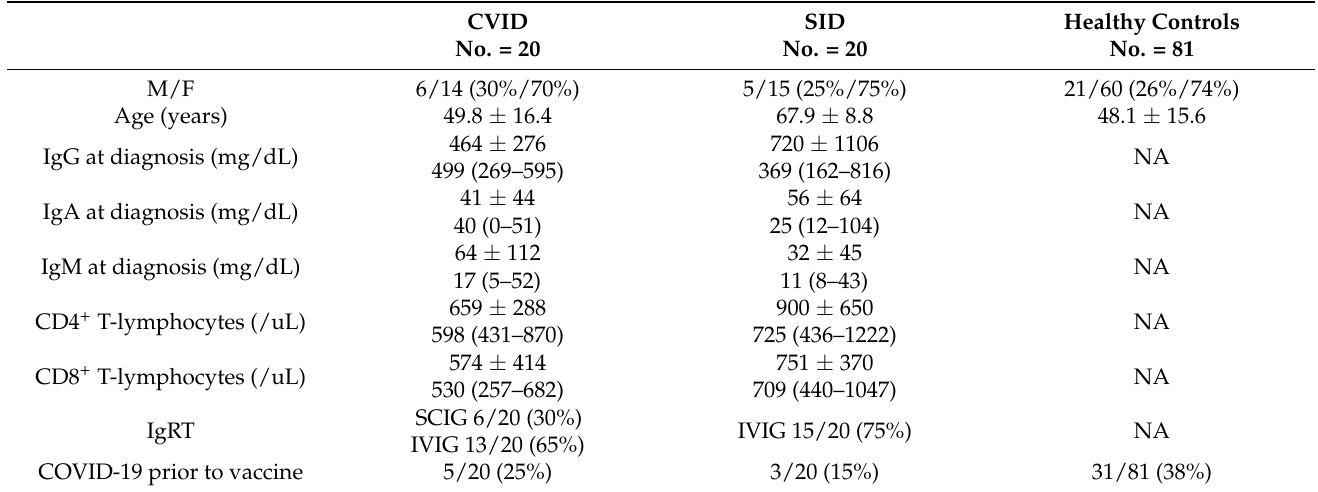
Table 1. Epidemiological features of the three study